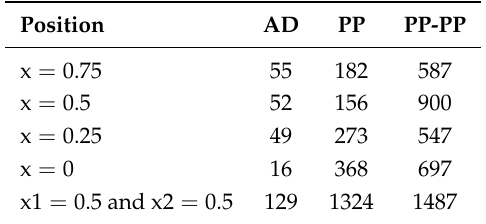
Boundary voltage changes (mV) for the three different drive patterns at different target